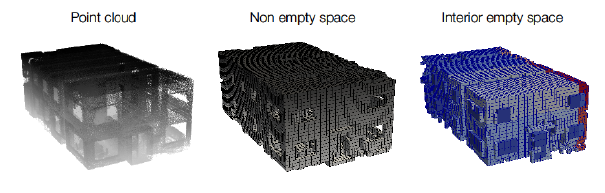
Figure 1: Process of point cloud to empty space